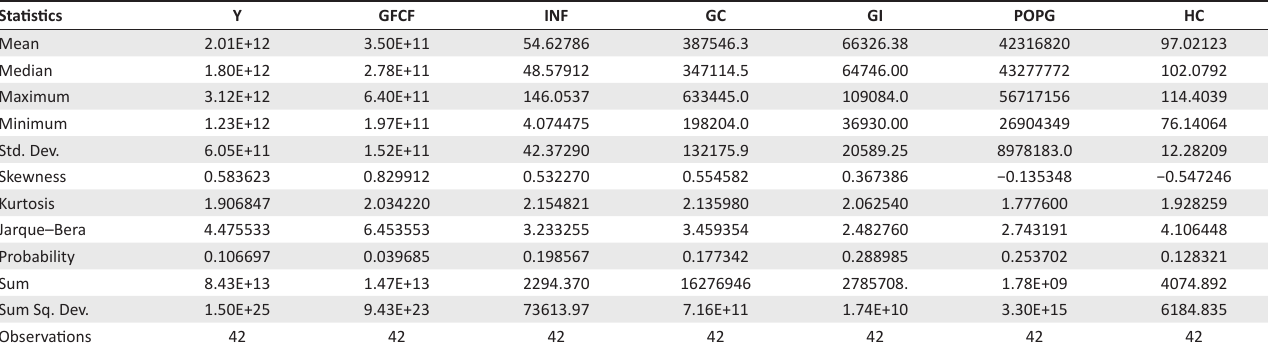
TABLE 1: Descriptive statistics: